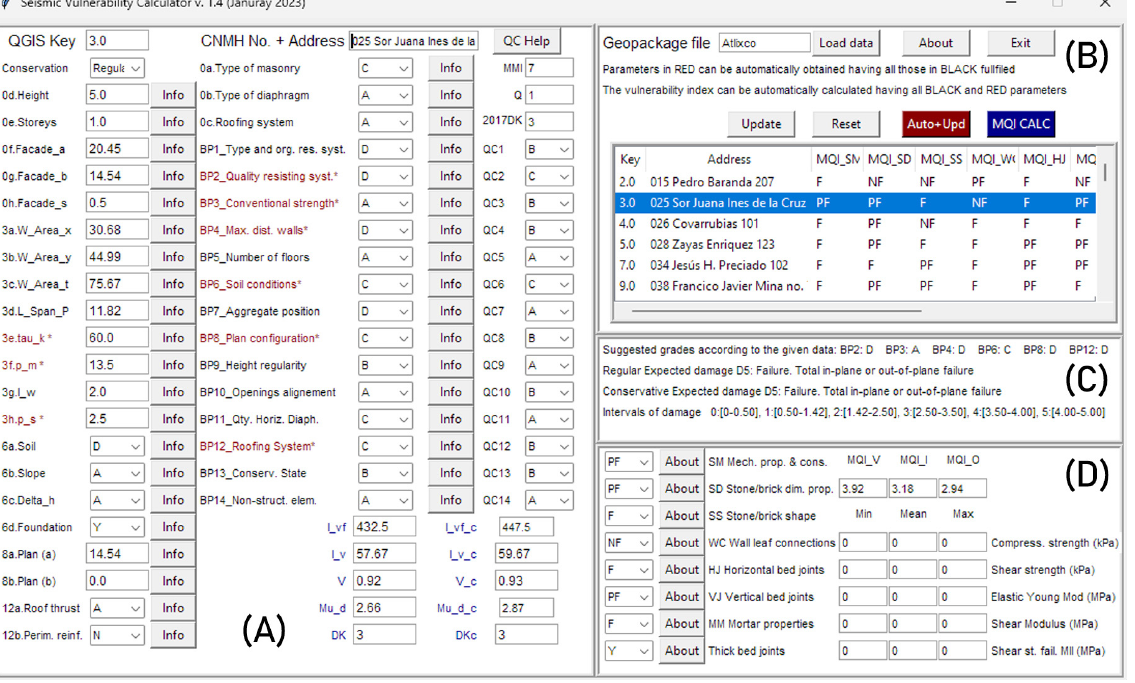
Figure 3. The main window of the seismic vulnerability calculator and the display modules ( A – D ).